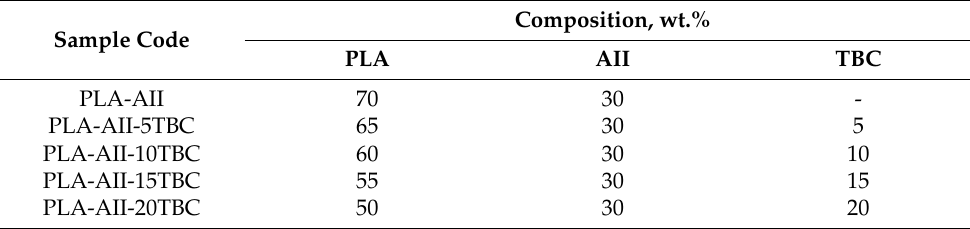
Table 1. Codes and the compositions of samples plasticized with different amounts of TBC. Sample